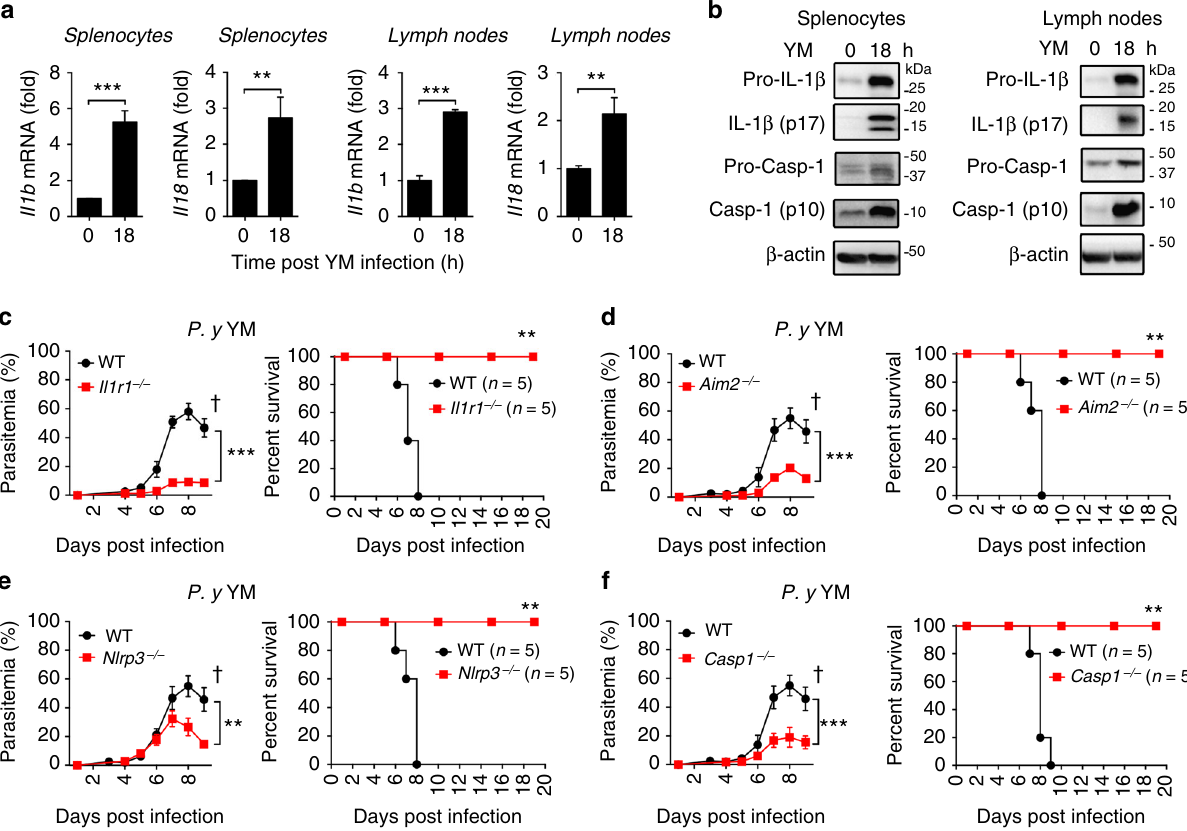
Fig. 1 In fl ammasome de fi ciency augments the resistance to lethal P. yoelii YM infection in vivo. a , b WT ( n = 5) mice were intraperitoneally infected with P. yoelii YM (0.5 × 10 6 iRBCs); spleen and lymph nodes were collected at indicated times post infection and subjected to qPCR ( a ) and immunoblotting analyses ( b ). c – f WT and Il1r1 − / − ( c ), Aim2 − / − ( d ), Nlrp3 − / − ( e ), Casp1 − / − ( f ) mice ( n = 5) were intraperitoneally infected with P. yoelii YM (0.5 × 10 6 iRBCs). Daily parasitemias and mortality rates are monitored. Data are representative of three independent experiments and plotted as mean ± SD. ** p < 0.01, *** p < 0.001 vs. corresponding control. Dagger denotes mouse